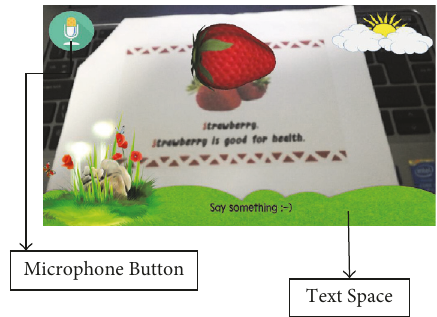
Figure 1: Main interface.